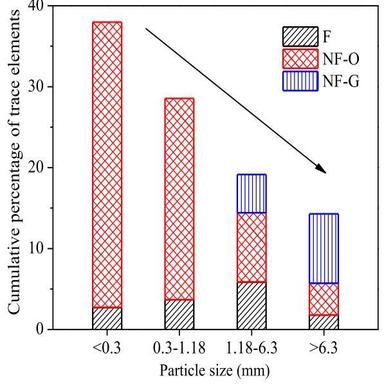
Distribution of trace elements in each particle size class of classified IBA.